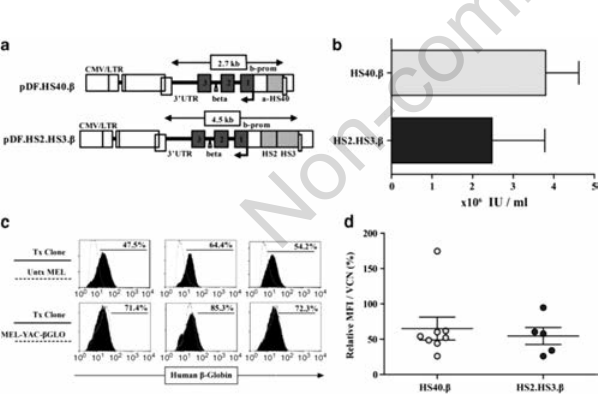
Figure 1. FV vector performance in the Murine Erythroleukemia cell line.(a) Diagram of pDF.HS40.b and pDF.HS2.HS3.b FV vec- tors. (b) Vector titers expressed as HT1080 integrating units per ml calculated by Taqman real-time PCR. Error bars indicate s.e.m. (c) Flow cytometry analysis for the expression of human b - globin in representative FV-transduced MEL clones. In the upper panel, filled histograms show transduced MEL cell clones over untrasduced control MEL cells (dotted line), whereas in the lower panel, filled histograms show individual clones layed over the MEL-YAC-bGLO cell line that is used as a positive control (dot- ted line). (d) Human b -globin levels in single HS40.b- or HS2.HS3.b-transduced MEL clones presented as antibody mean fluorescence intensity increase over the negative control per inte- grated vector.